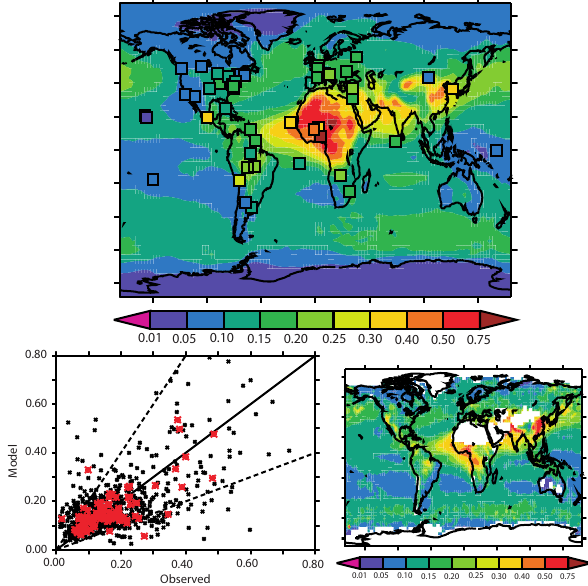
Fig. 15. (a) Annual mean AOD modelled with GMXe for the year 2001, over-plotted are annual mean measurements from the AERONET network (2001), (b) summary of the comparison be- tween GMXe and AERONET, black points are monthly mean and red are annual mean ( r 2 =0.51). (c) Annual mean AOD from MODIS for